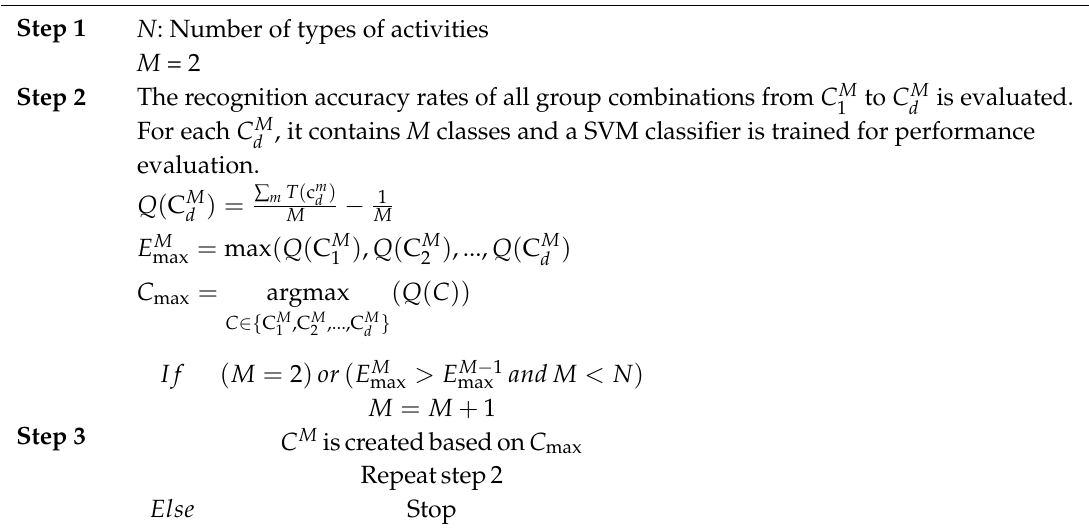
Algorithm 1. Algorithm of Group